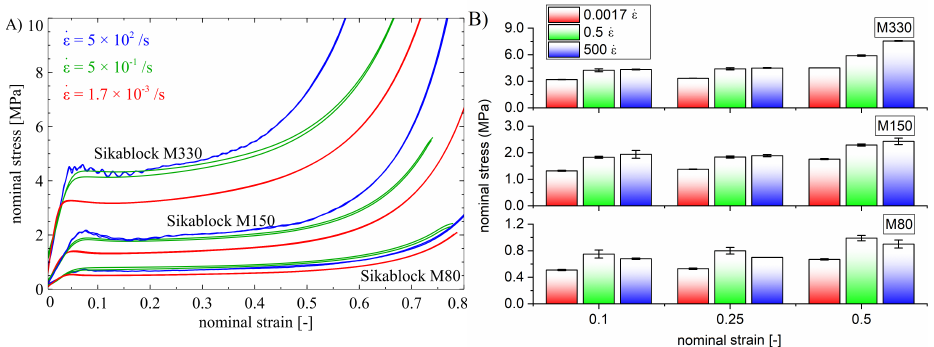
Figure 5: A ) Stress-strain data for foams M80, M150 and M330 obtained at strain rates of 0.0017 / s, 0.5 / s, and 500 / s. B ) compares stress values at three selected strain values, ε = 0.1, 0.25, and 0.5, to emphasize the non-monotonic relation of stress to strain rate for the lower density foams M80 and M150.